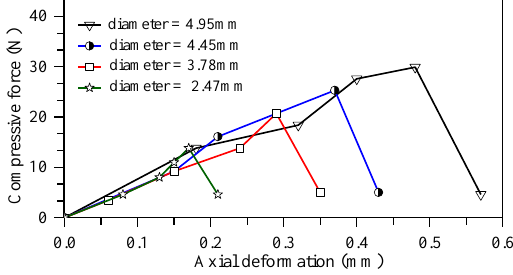
Fig. 3. Typical compressive force - axial deformation curves in experiments.